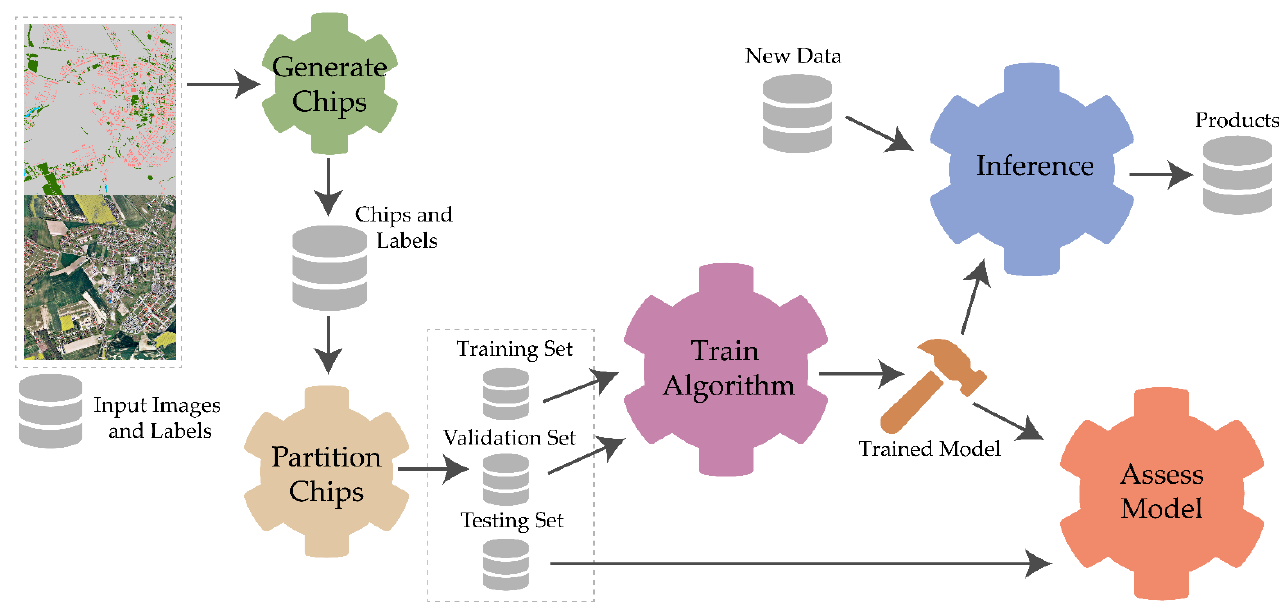
Figure 2. Conceptualization of DL workflow including chip generation, data partitioning, training, model assessment, and inference to new data. Example data are from the LandCover.ai dataset [14]. Database and hammer icons are from Font Awesome and made available under a CC by 4.0 license.